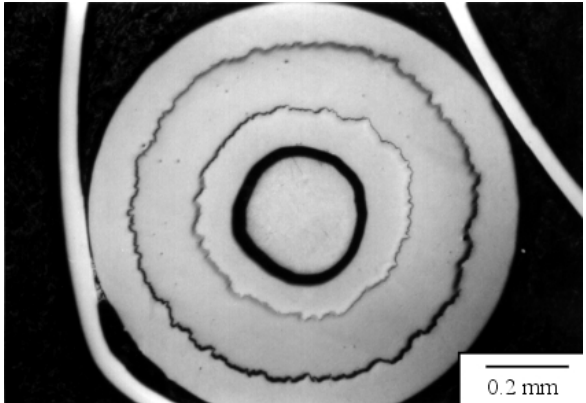
Figure 2. Monofilament with 1.0 mm after drawing operation. The shine material with dark contour in the center is Sn, the next phase is Cu, the third phase with irregular contour is NbTa and the outer layer is Cu.